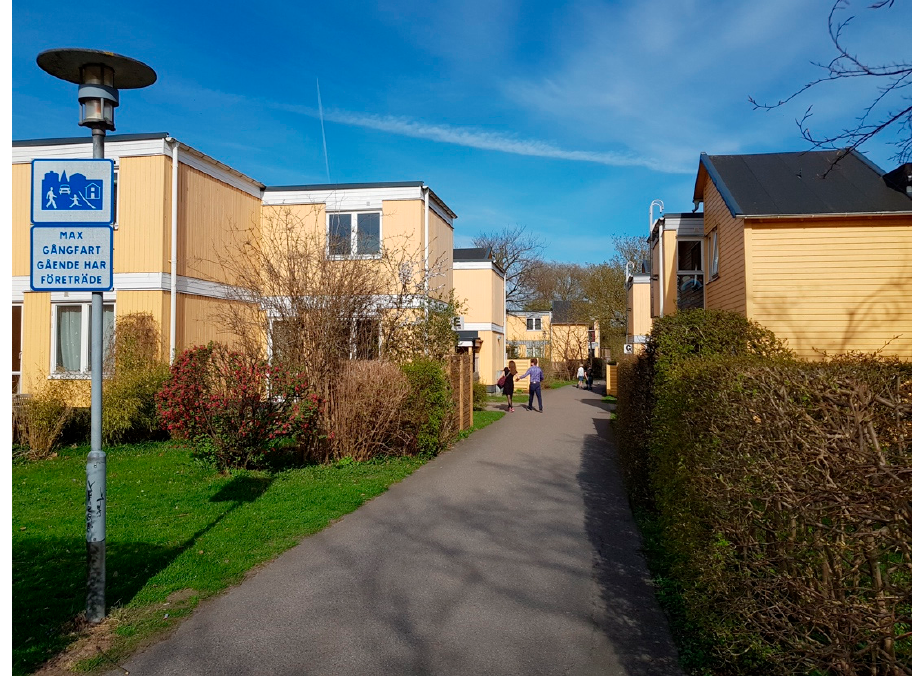
Figure 24. Lower density style neighbourhood in Lund in the Malmö metropolitan area. Source: Jeffrey Kenworthy.